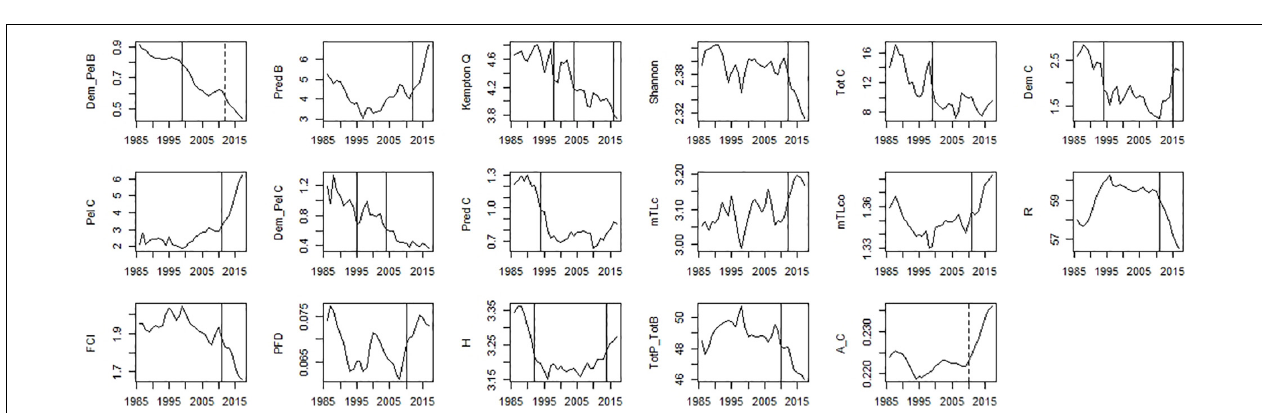
FIGURE 7 | Time-series of modelled biomass data. Significant shifts detected by STARS analysis are displayed on the plots as solid and dashed vertical line for shifts significant at p ≤ 0.05 and ≤ 0.1, respectively. Abbreviations, used in the figure, are explained in Supplementary Table 4 .